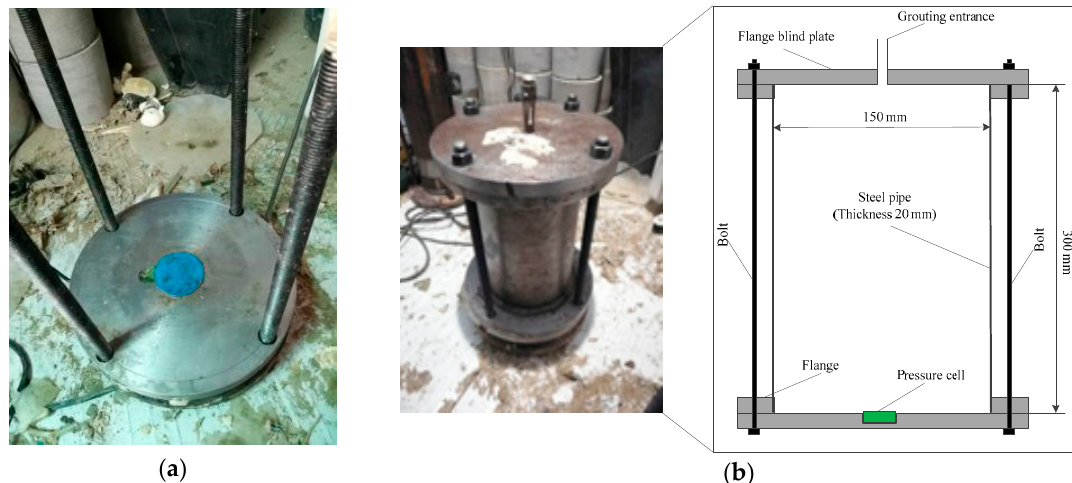
Figure 1. Schematic diagram of the expansion force test. ( a ) Placement of the pressure cell; ( b ) Molds for testing.